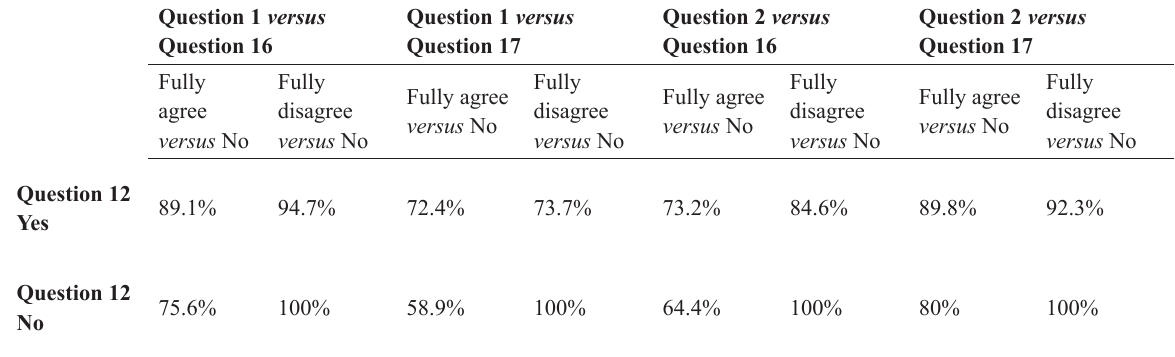
Larger percentage verified for respondents who marked “fully agree” and “fully disagree” (Question 1 and Question 2) versus “no” (Question 16 and Question 17) crossed with the responses to Question 12